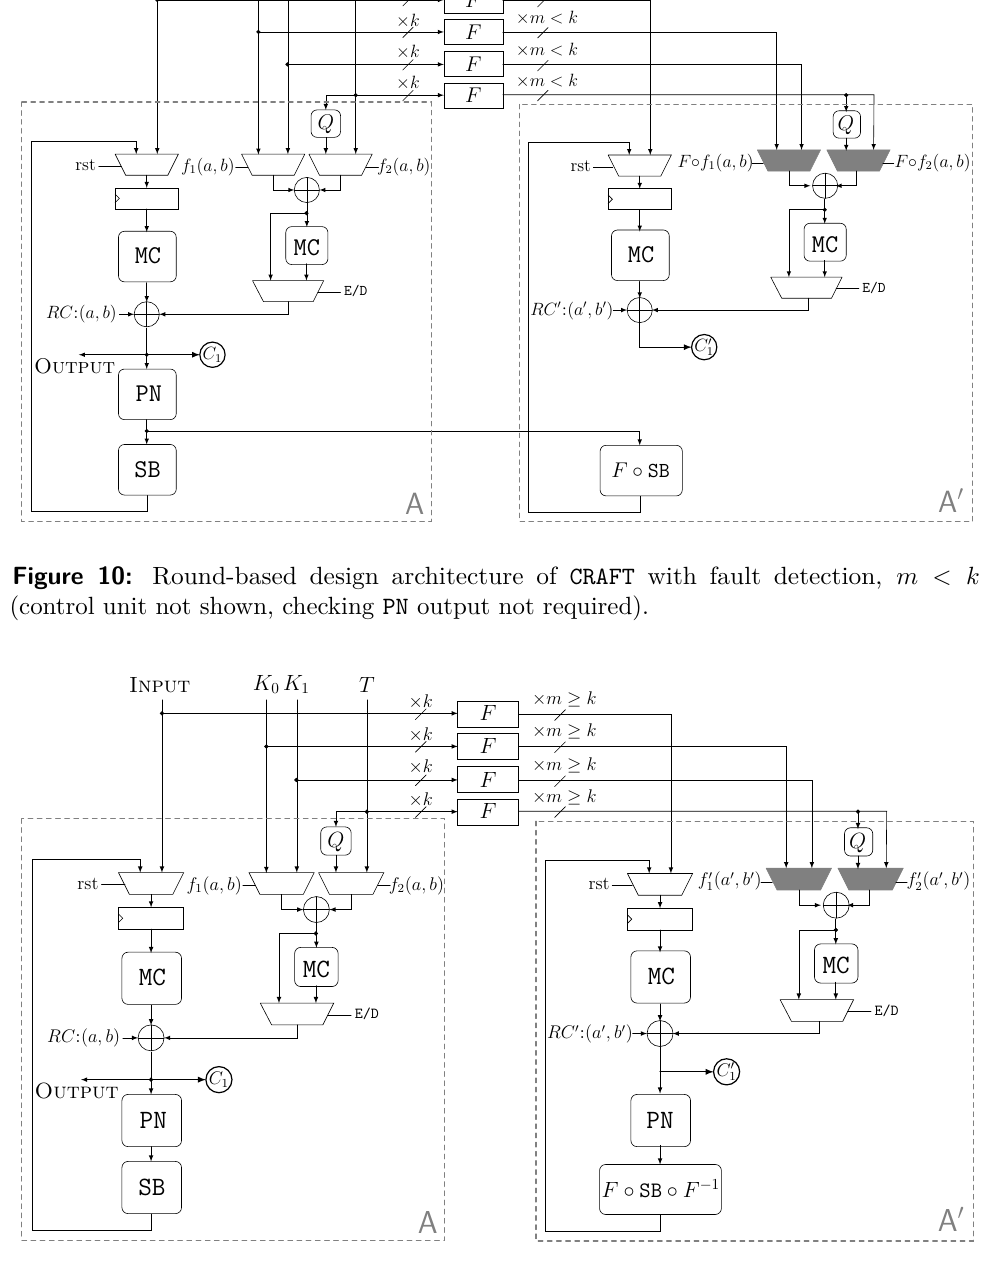
Figure 11: Round-based design architecture of CRAFT with fault detection, m ≥ k (control unit not shown, checking PN output not